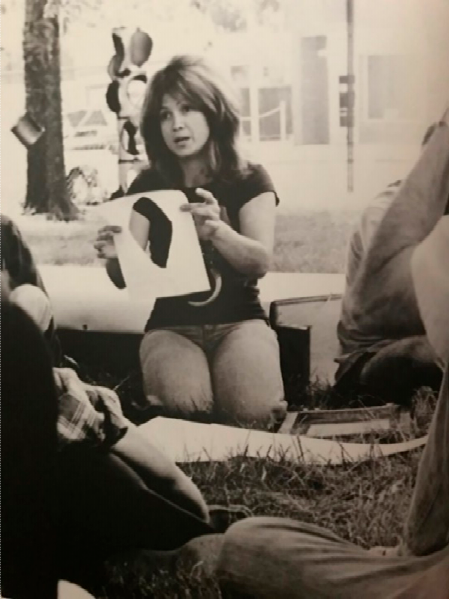
Figure 2. Josely Carvalho at a silkscreen public interactive event as a community artist-in-residence in Arlington, VA, a pilot-project grant from the National Endowment for the Arts, 1974. Courtesy of the artist.